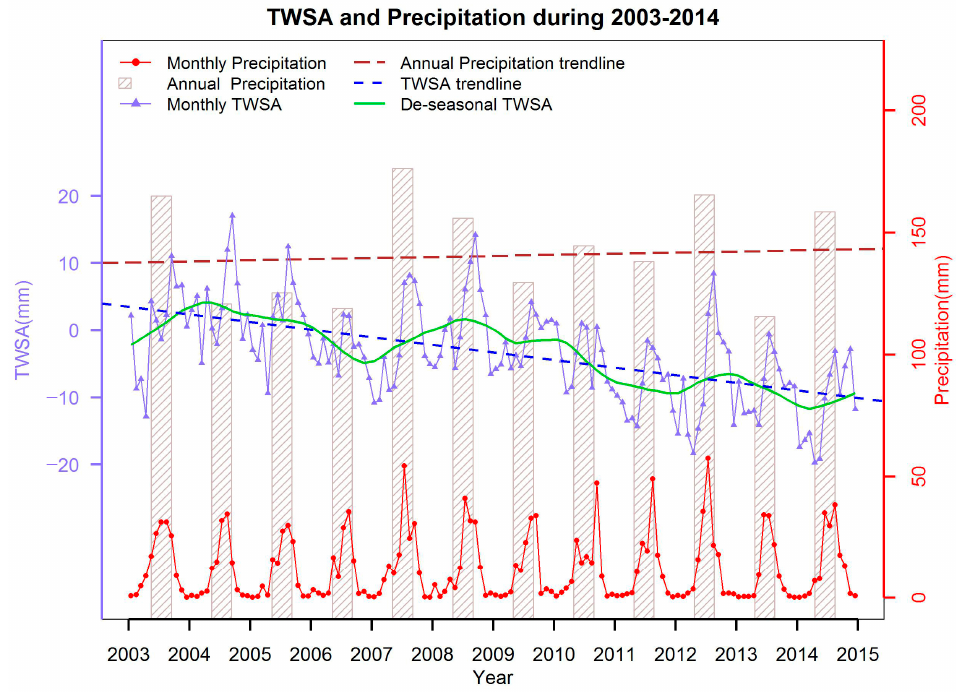
Figure 3. Monthly TWSA (solid blue line) averaged over the BJD from 2003 to 2014 with a green line indicating the smoothed and deseasonalized TWSA. The dark blue dashed line is the linear trend of the deseasonalized TWSA. The red line is the monthly precipitation and gray bars are the annual accumulated precipitation.